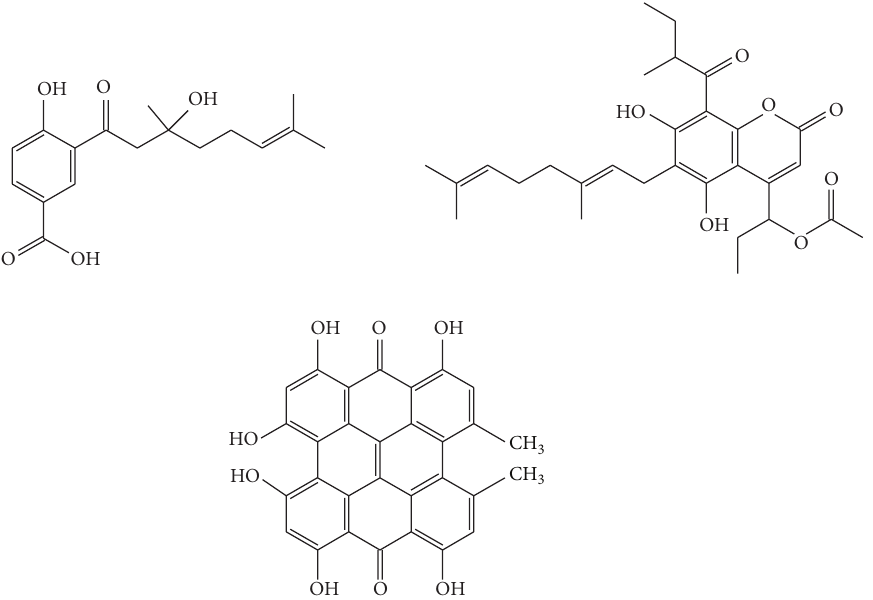
Figure 4: Examples of natural antifungals extracted from plants